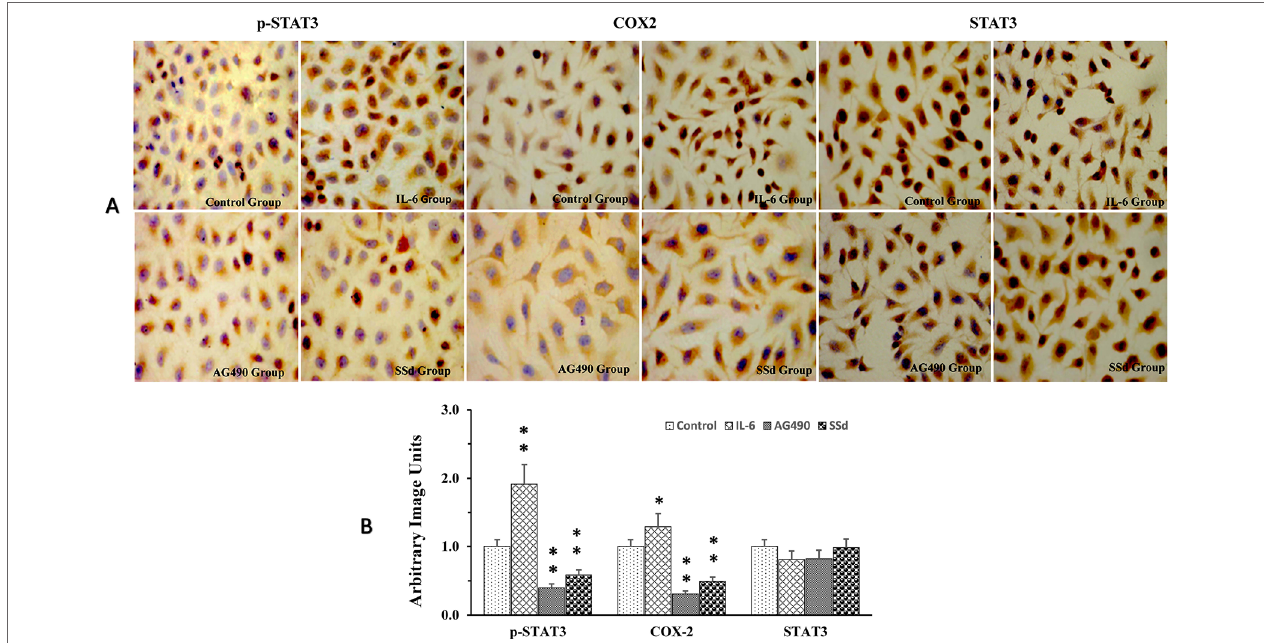
FIGURE 3 | Alteration of p-STAT3, COX-2, and STAT3 expression post-treatment with SSd. (A) Representative images of immunocytochemical staining of SMMC- 7721 cells pre- and post-treatment with AG490, SSd, and IL-6. Control group: Cells treated with PBS; IL-6 group: Cells treated with IL-6 (25 ng/ml); AG90 group: Cells treated with IL-6 (25 ng/ml) + AG490 (25 μmol/L); and SSd group: Cells treated with IL-6 (25 ng/ml) + SSd (5 μg/ml). DAB used as chromogen; original magnification ×200: nuclear immunoreactivity. (B) Results from quantitative analysis of images using ImagePro Plus 7.1 software and data were expressed as arbitrary image units. ** P < 0.01, * P < 0.05 compared to the control. Nucleus was stained using hematoxylin (blue), antibody staining